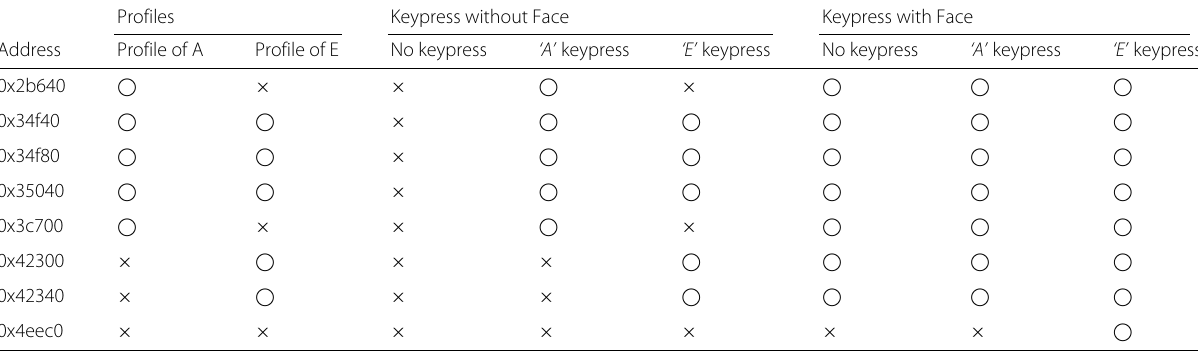
Table 3 Effect of Face during the exploitation phase of keypress logging attack on a and e Profiles Keypress without Face Keypress with